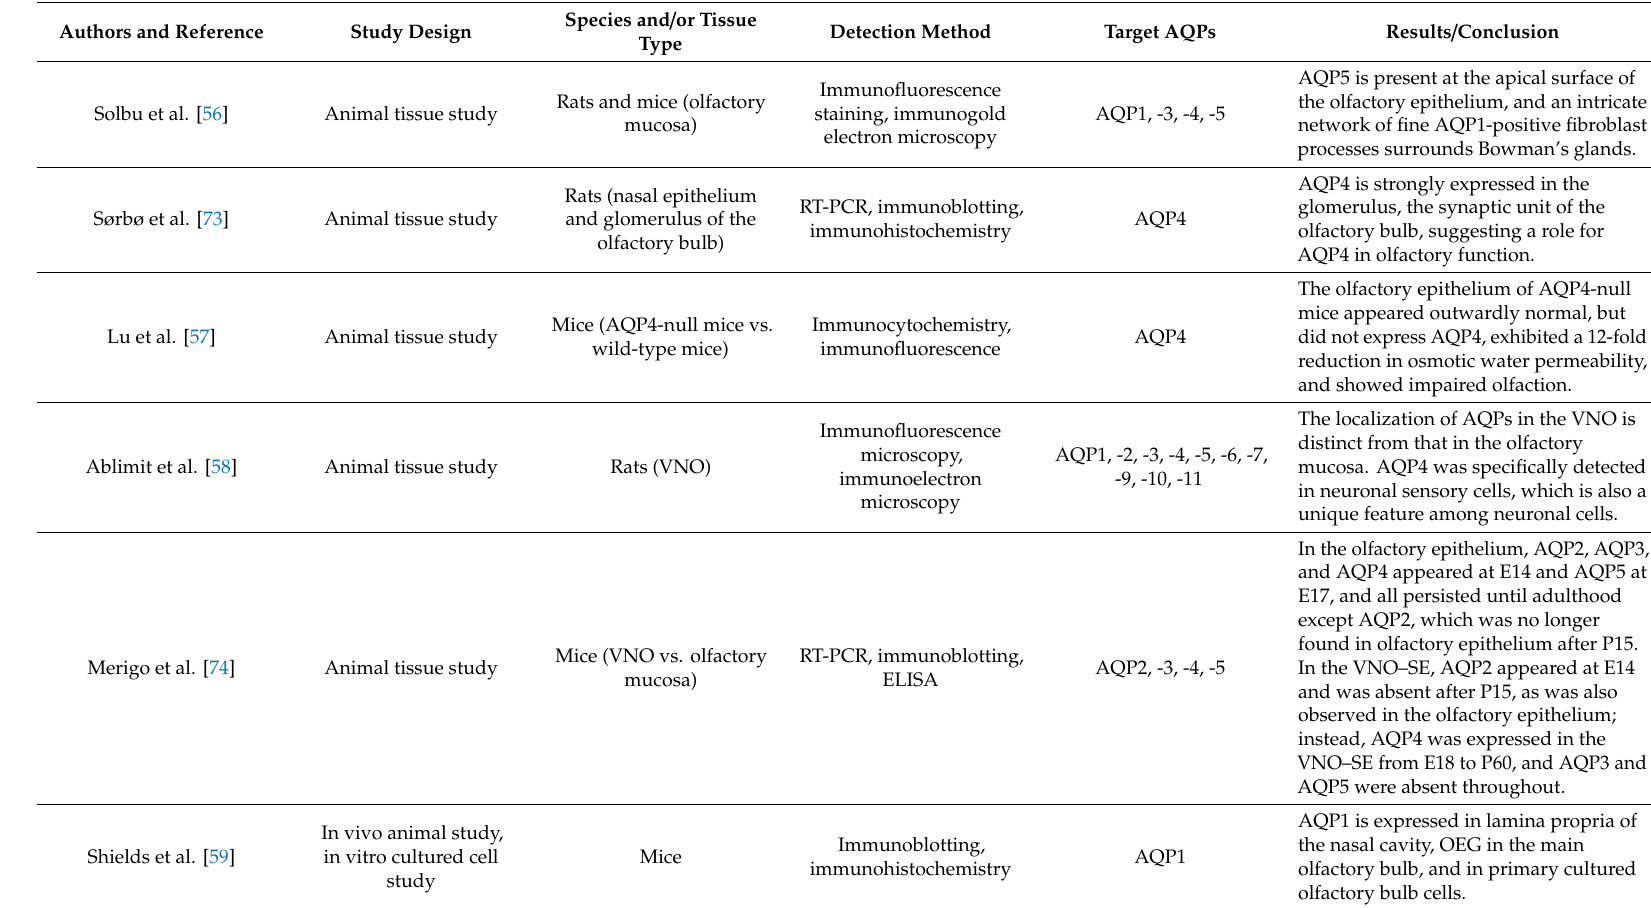
Table 4. Studies assessing the relationship between AQPs and